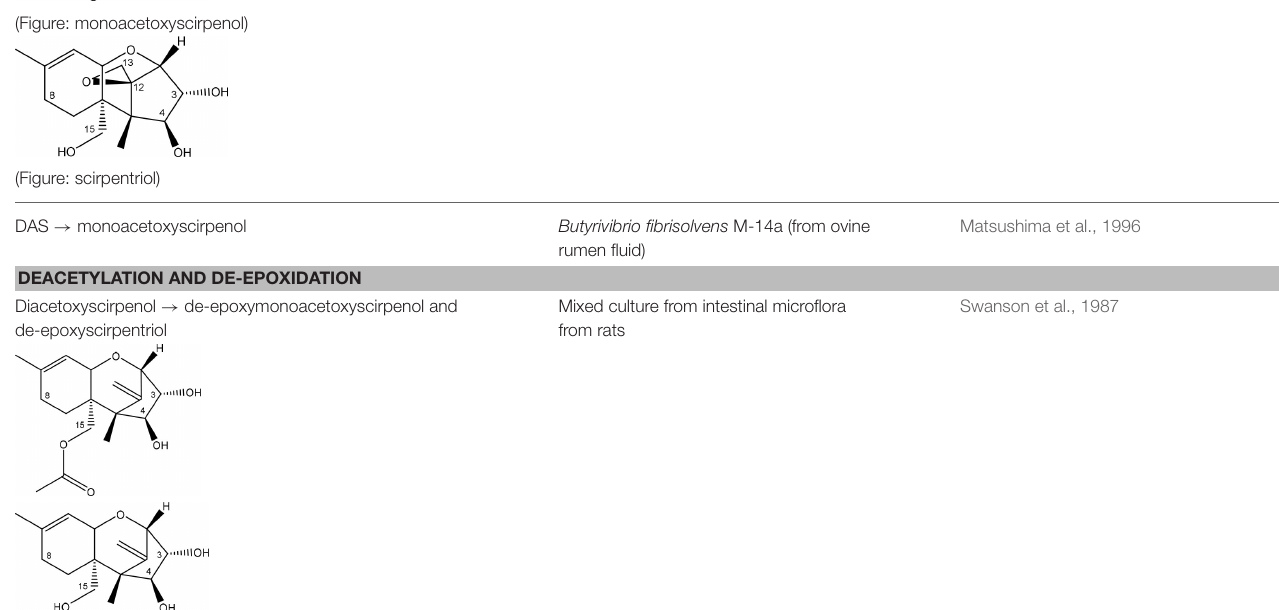
(Figure: monoacetoxyscirpenol)